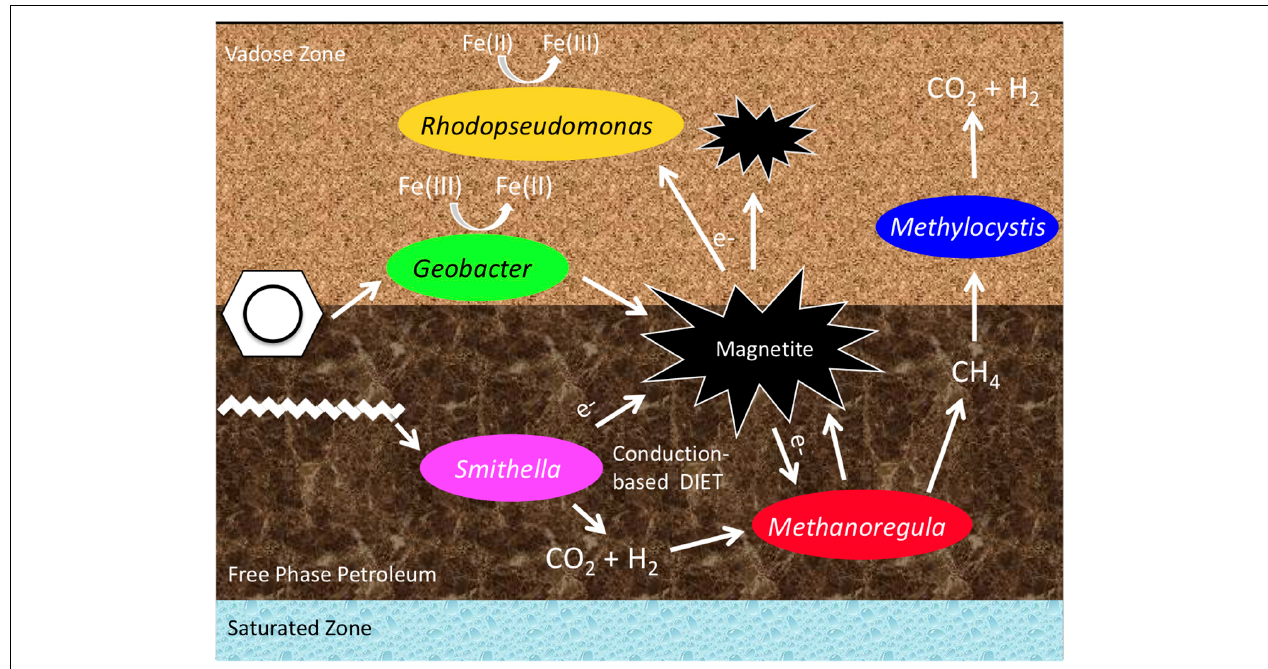
FIGURE 7 | Conceptual model of the predominant bacteria and the metabolic processes in and above the free-phase oil zone.